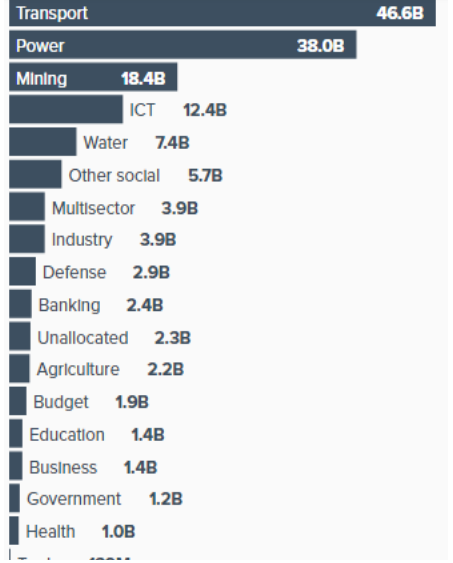
Figure 4: Investments made by China in Africa between 2000 and 2019 (Source: John Hopkins (SAIS-CARI) – Boston University Global Development Policy Center